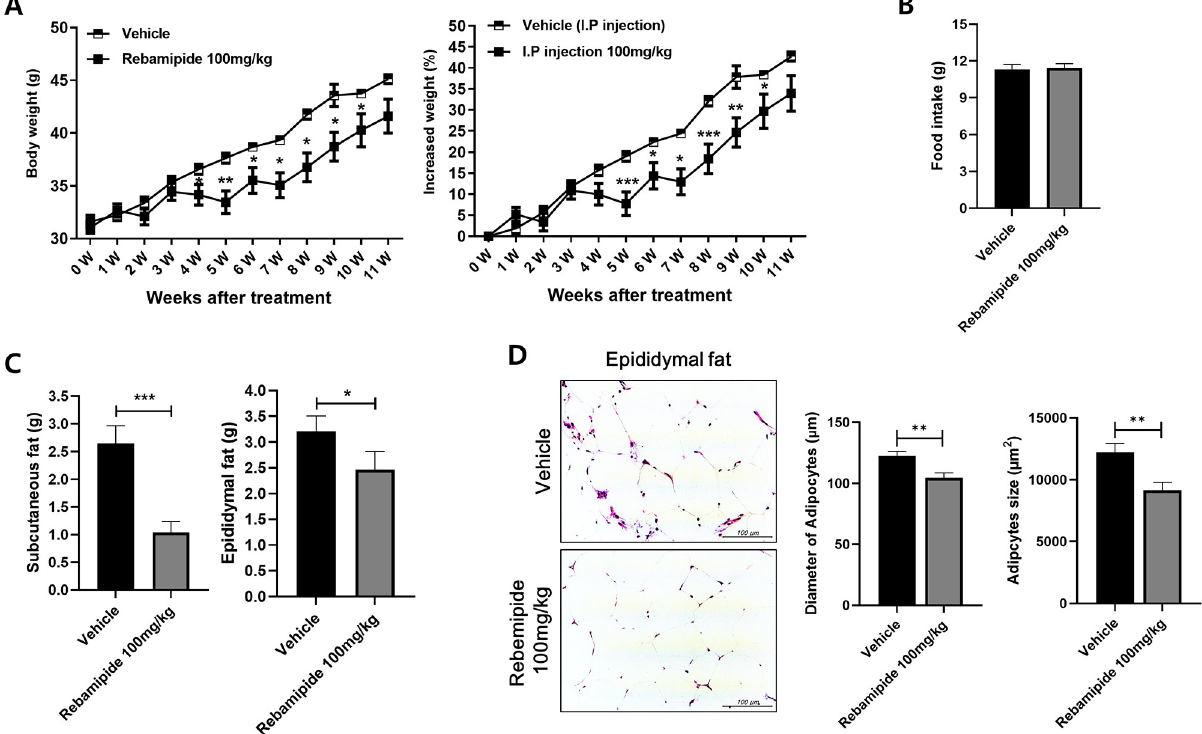
Fig 1. Protective effect against high-fat diet obesity of rebamipide. (A) Body weight and the ratio of increased weight of body weight were presented for 11 weeks. (B) Food intake in the rebamipide treatment group and vehicle group. (C) The subcutaneous fat and epididymal fat at the end of the experiment after 100mg/kg of rebamipide treatment. (D) H&E images of epididymal adipose tissues showed the crown-like structure, diameter, and size of adipocytes. � P < 0.05, �� P < 0.01 and ��� P < 0.005.